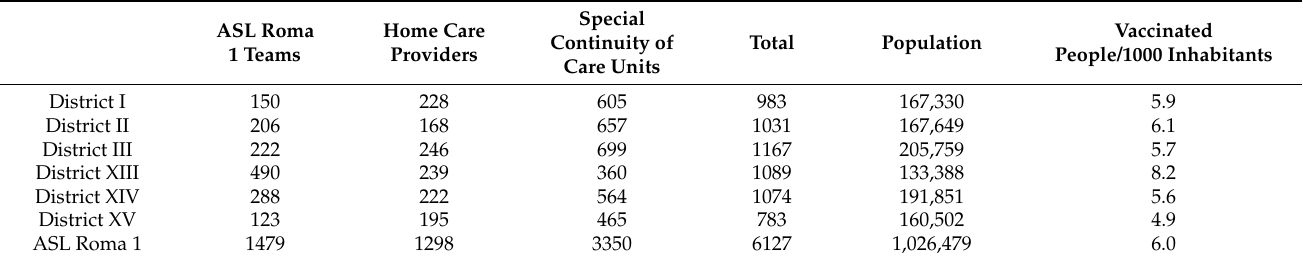
Table 1. Number of people (only first dose) vaccinated per health district/ASL Roma 1 and per provider. People vaccinated per 1000